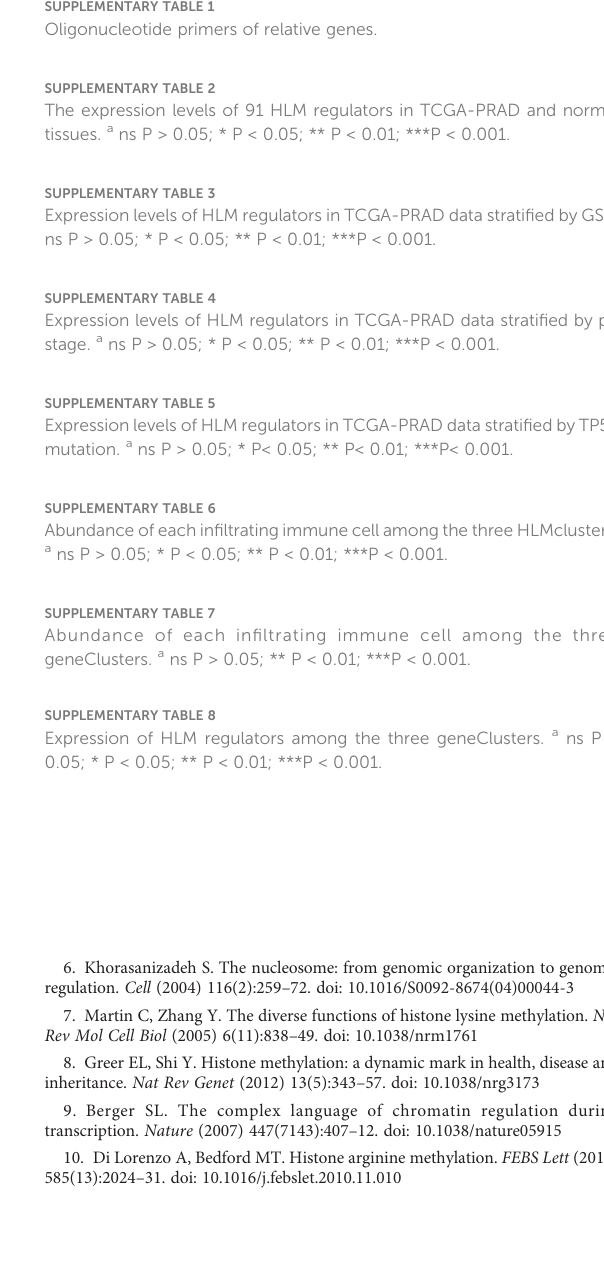
SUPPLEMENTARY TABLE 1 Oligonucleotide primers of relative genes.